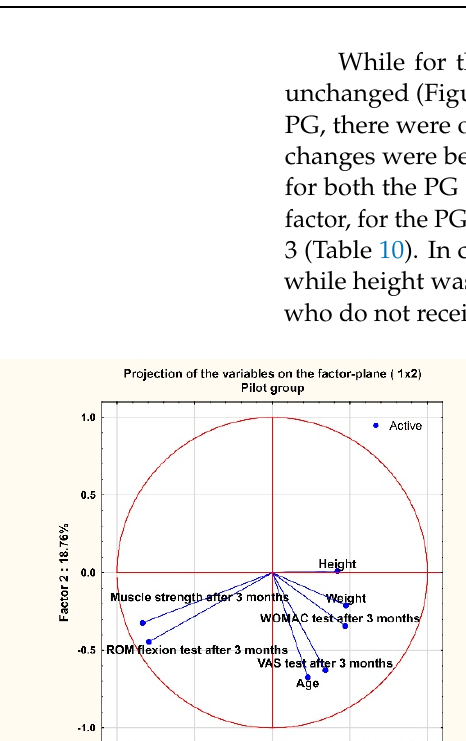
Table 9. Factor coordinates of the variables based on correlations for the control group (CG) at the initial stage.